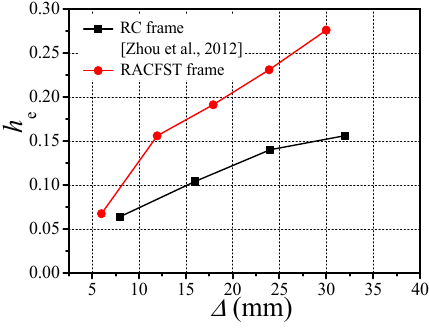
Figure 13. The energy dissipation capacity.